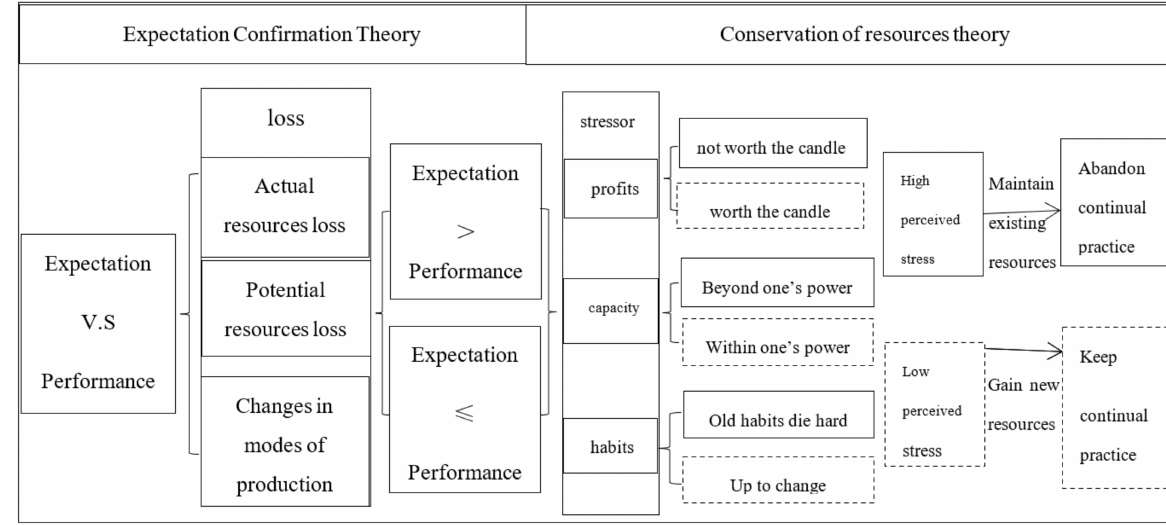
Figure 1. Theoretical